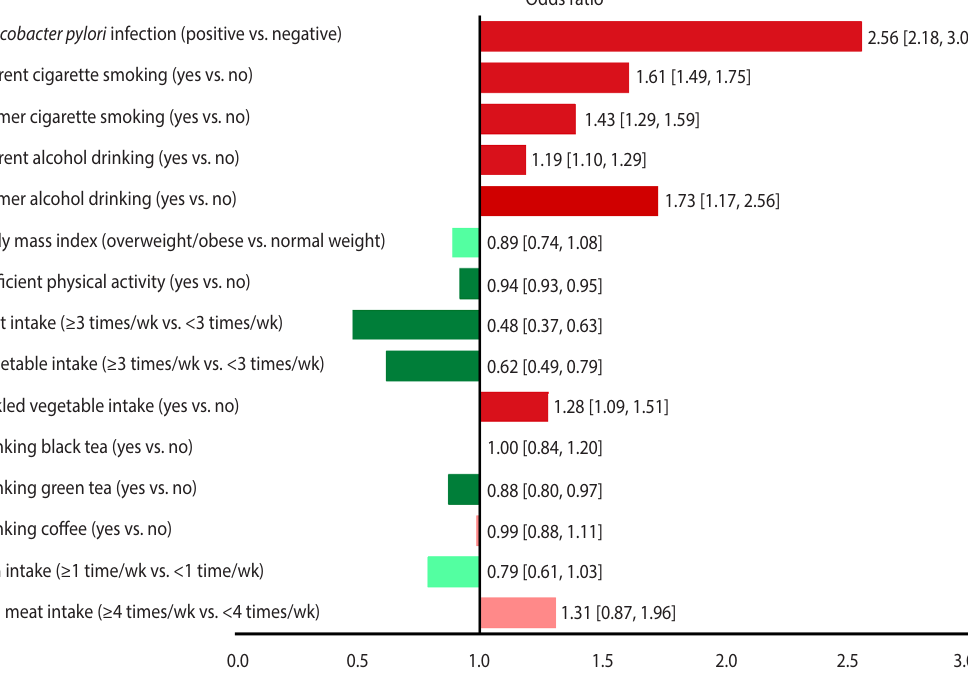
Figure 3. The associations (95% confidence intervals) between stomach cancer and nutritional and behavioral factors in a single view. Protective factors are shown in green (dark green, significant; light green, non-significant) and risk factors are shown in red (dark red, sig- nificant; light red,